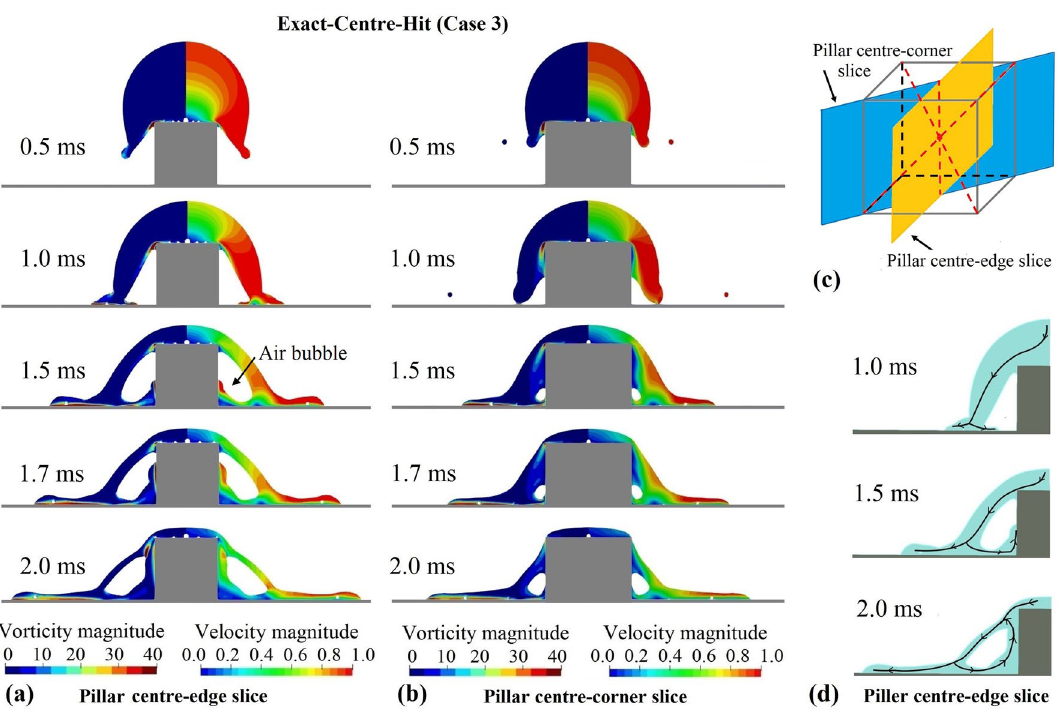
Figure 5. Flow field of a D = 2 mm isopropanol droplet, impacting onto a 1 mm × 1 mm × 1 mm cubic pillar embedded on a flat surface. The collision point lies at the centre of the pillar top. The contact angle is 0 ◦ , satisfying the full-wetting condition. We = 159 and Re = 1119 . ( a ) Dimensionless vorticity field 2 D | ω | / U 0 (left) and dimensionless velocity field | V | / U 0 (right) for a slice across the pillar centre and the centre of the pillar edges. ( b ) Dimensionless vorticity field 2 D | ω | / U 0 (left) and dimensionless velocity field | V | / U 0 (right) for a slice across the pillar centre and the corners of the pillar. ( c ) Position of the two slices in ( a ) and ( b ) through the cubic pillar. ( d ) Schematic streamline direction for the same slice as shown in ( a